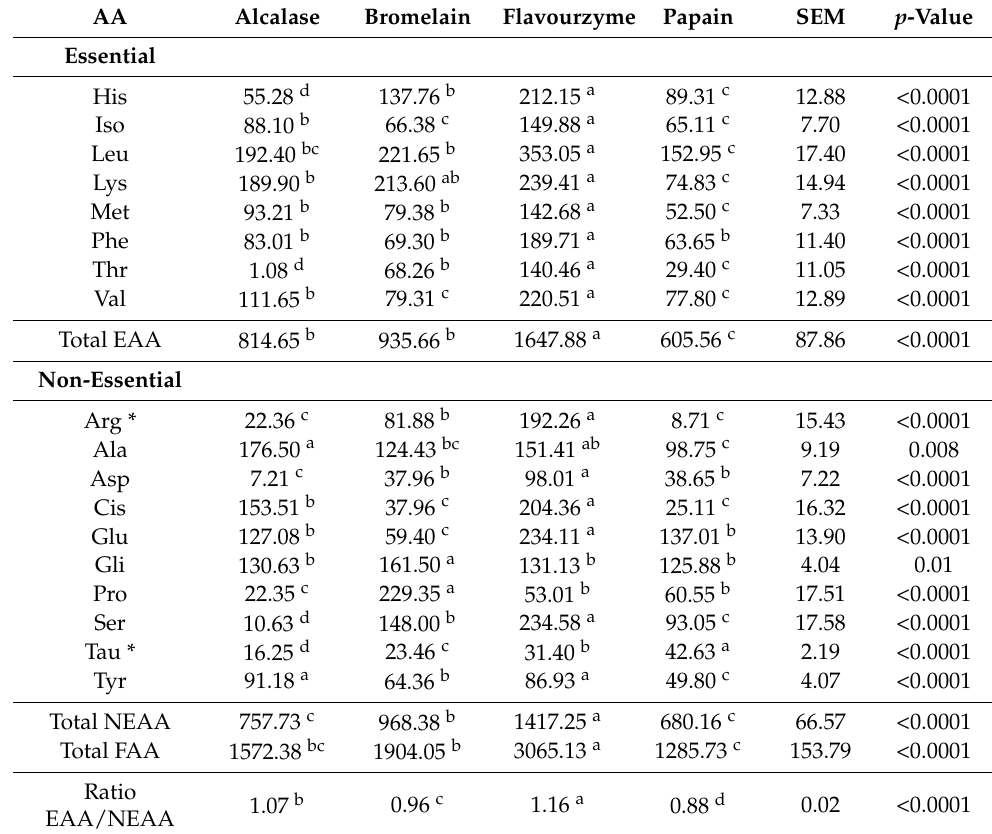
Table 1. Free amino acid profile of liver (mg/100 g liver) from hydrolysis treatment with different enzymes (alcalase, bromelain, flavourzyme, and